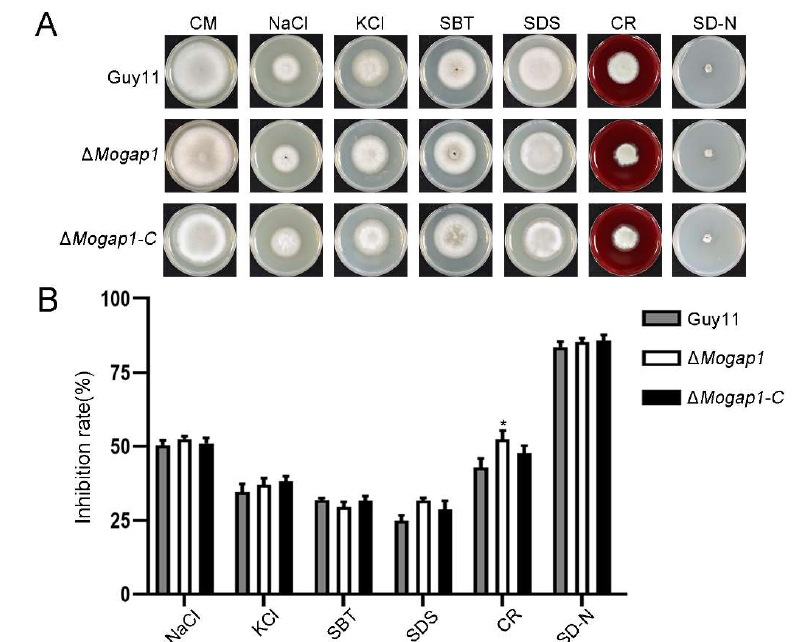
Figure 5. Effect of MoGap1 on CWI. ( A ) The growth performance of Guy11, ∆ Mogap1 , and ∆ Mogap1- C under hypertonic stress (NaCl medium, KCl medium, and SBT medium), cell wall stress (SDS medium and CR medium), or starvation stress (SD-N medium). ( B ) The inhibition rates of Guy11, ∆ Mogap1 , and ∆ Mogap1-C in different stress media, in which those between ∆ Mogap1 by CR and Guy11 were significantly different (* p < 0.05).